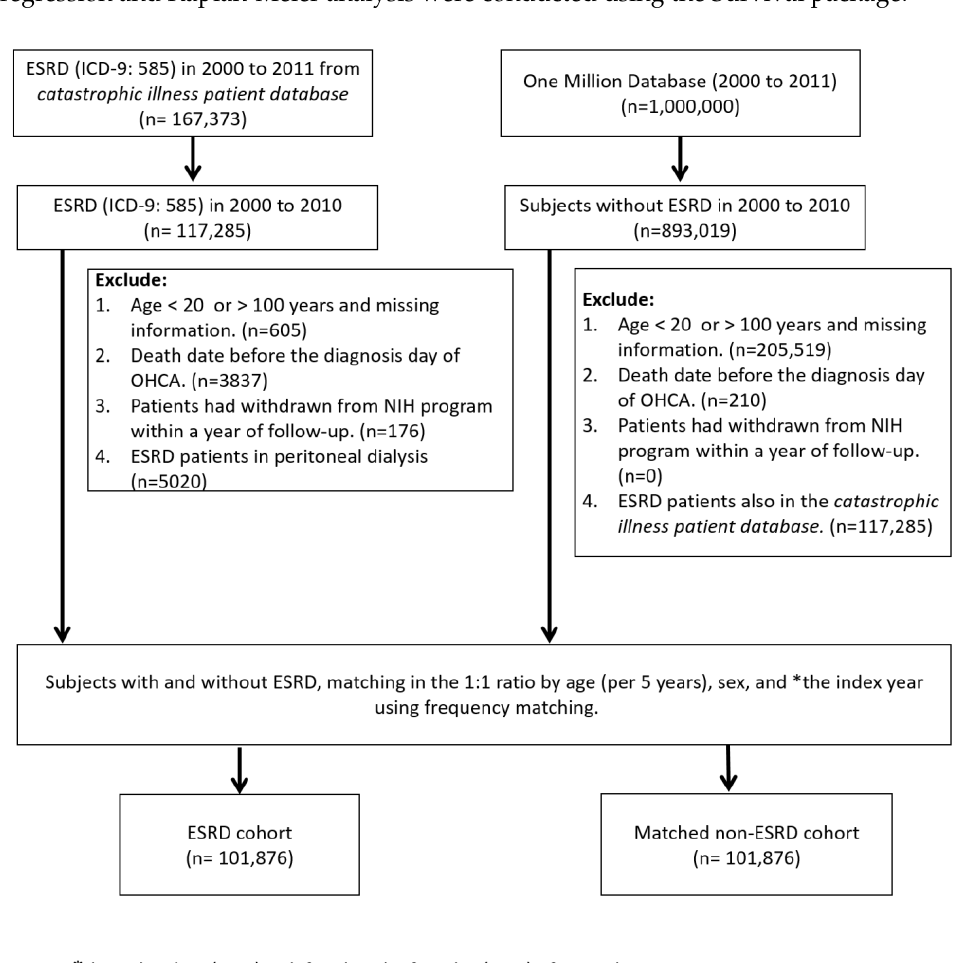
Figure 1. Selection algorithm for the matched ESRD in regular hemodialysis and non-ESRD patients. ESRD: End-stage renal-disease; OHCA: Out-of-hospital cardiac arrest; NIH: National Institutes of Health